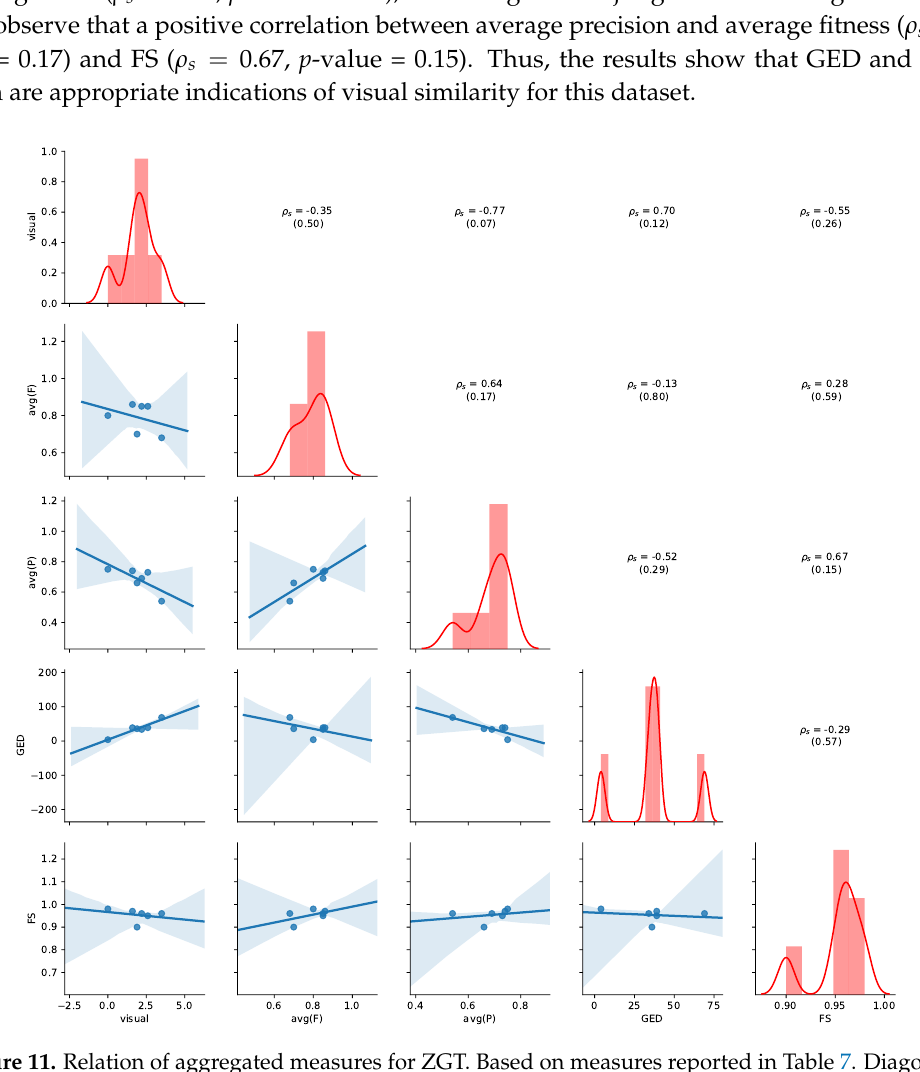
Figure 11. Relation of aggregated measures for ZGT. Based on measures reported in Table 7. Diagonal: normalized histogram and kernel density estimation of the distribution. Lower triangle: scatterplot with estimated linear regression line. Upper triangle: pairwise Spearman’s rank correlations ( ρ s ) with p